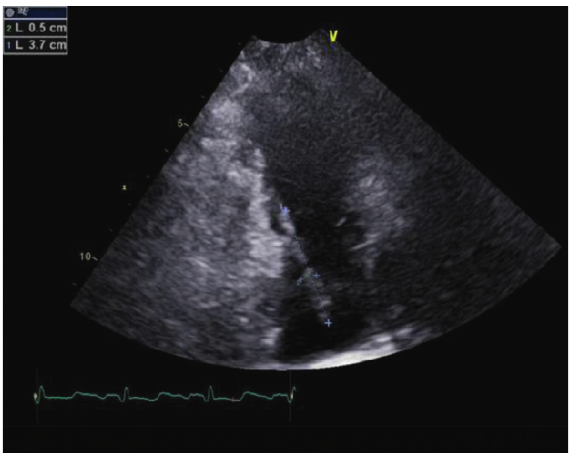
Figure 2: Transthoracic echocardiogram revealed extensive mobile 3.7 × 0.5cm vegetation in the pulmonary valve with moderate to severe pulmonic regurgitation mobile 3.7 × 0.5cm vegetation in the pulmonary valve with